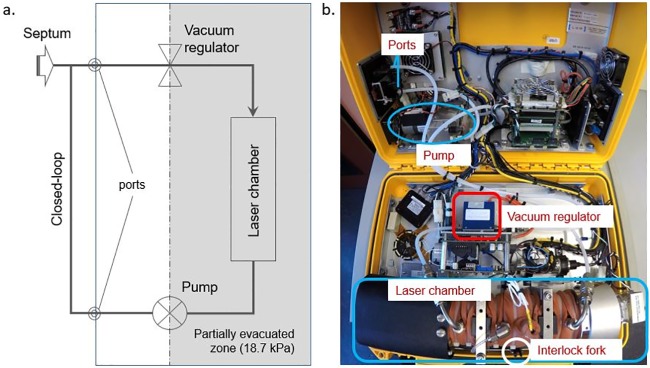
The UGGA system; a. simplified schematic of the UGGA gas loop (shaded area is the partially evacuated loop zone), and b.instrument case interior (note: image distorted due to wide-angle lens).